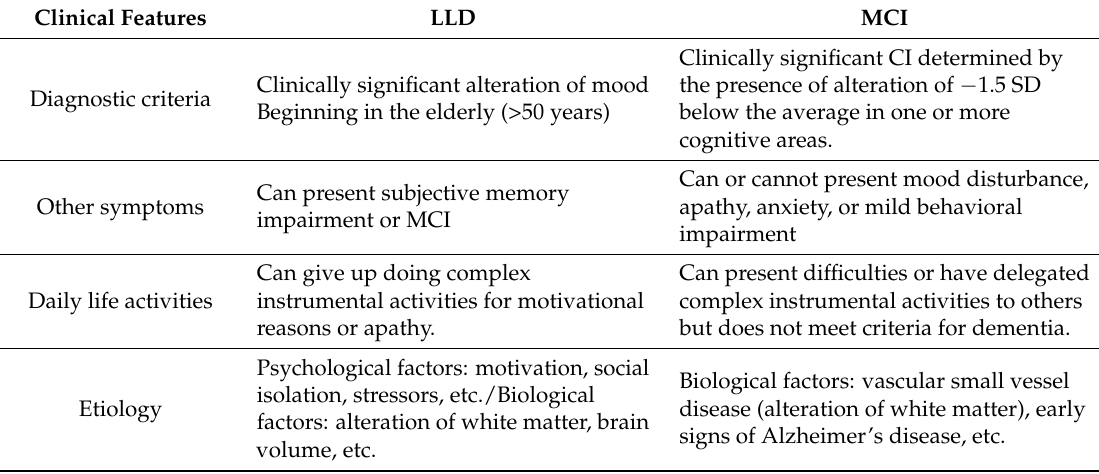
Table 1. Diagnostic criteria and clinical features in late-life depression (LLD) and mild cognitive impairment (MCI). CI = cognitive impairment; SD = standard